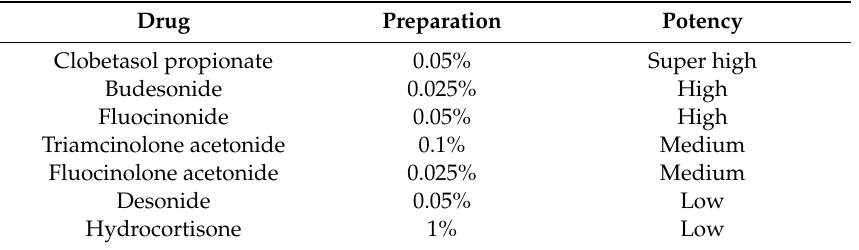
Table 2. Topical